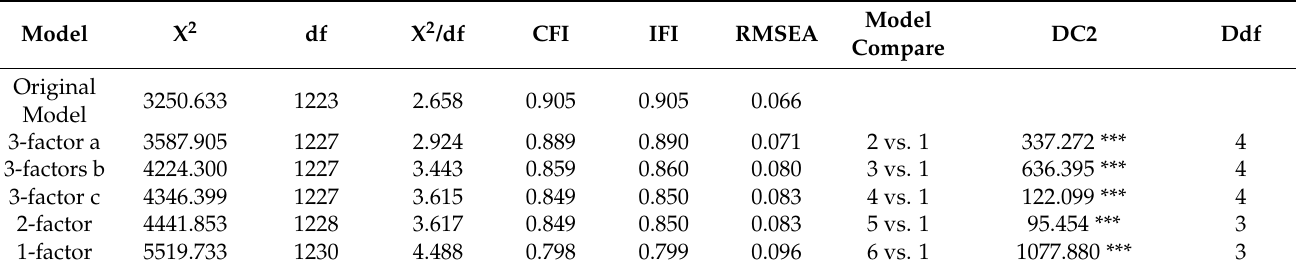
Table 2. Results of validation factor analysis.